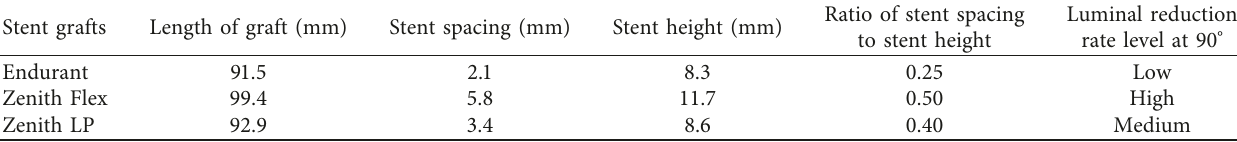
Table 5: Luminal reduction rate of commercial stent grafts.